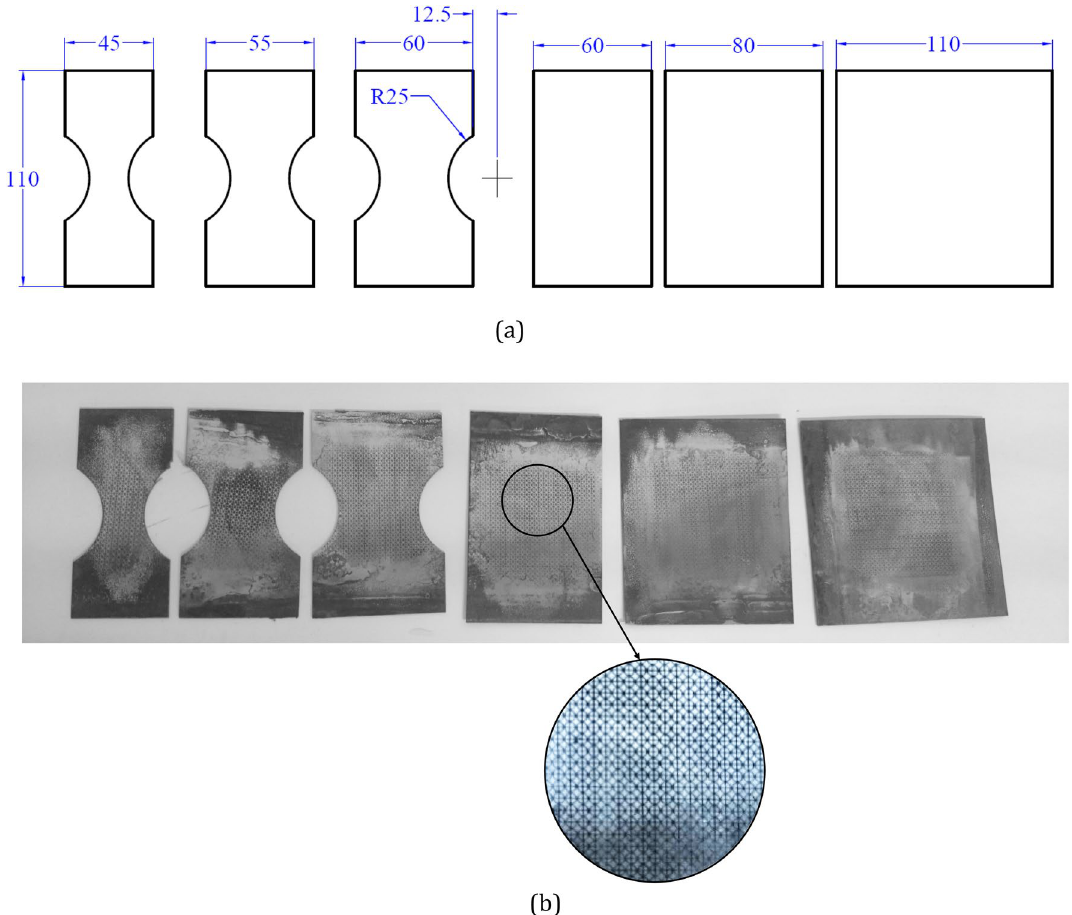
Figure 4. Nakazima’s forming limit samples dimensions and cut sheets. ( a ) dimensions, ( b ) cut and marked